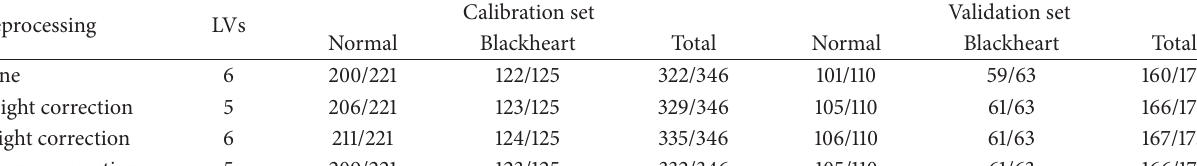
Table 3: Classification results based on PLS-LDA with different preprocessing methods and selected wavelengths.